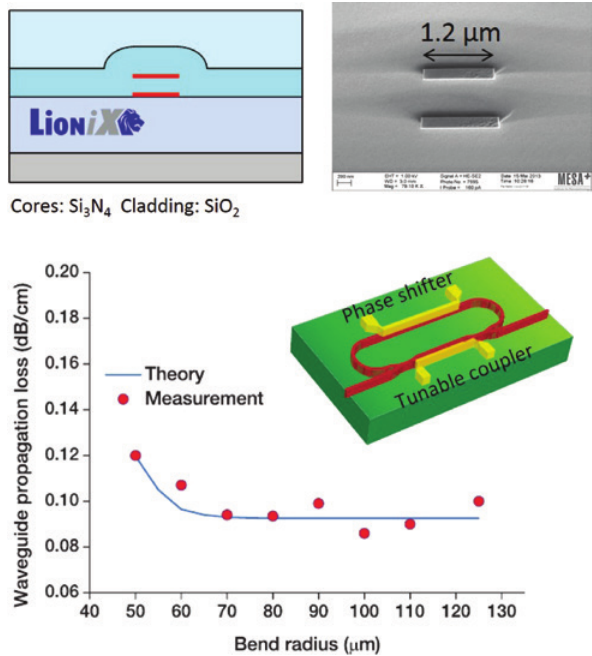
Figure 3: Schematic and scanning electron microscope photograph of the Si N /SiO waveguide cross-section and the waveguide losses 3 4 2 measured in ring resonators [38] (Copyright in 2010, Optical Society of